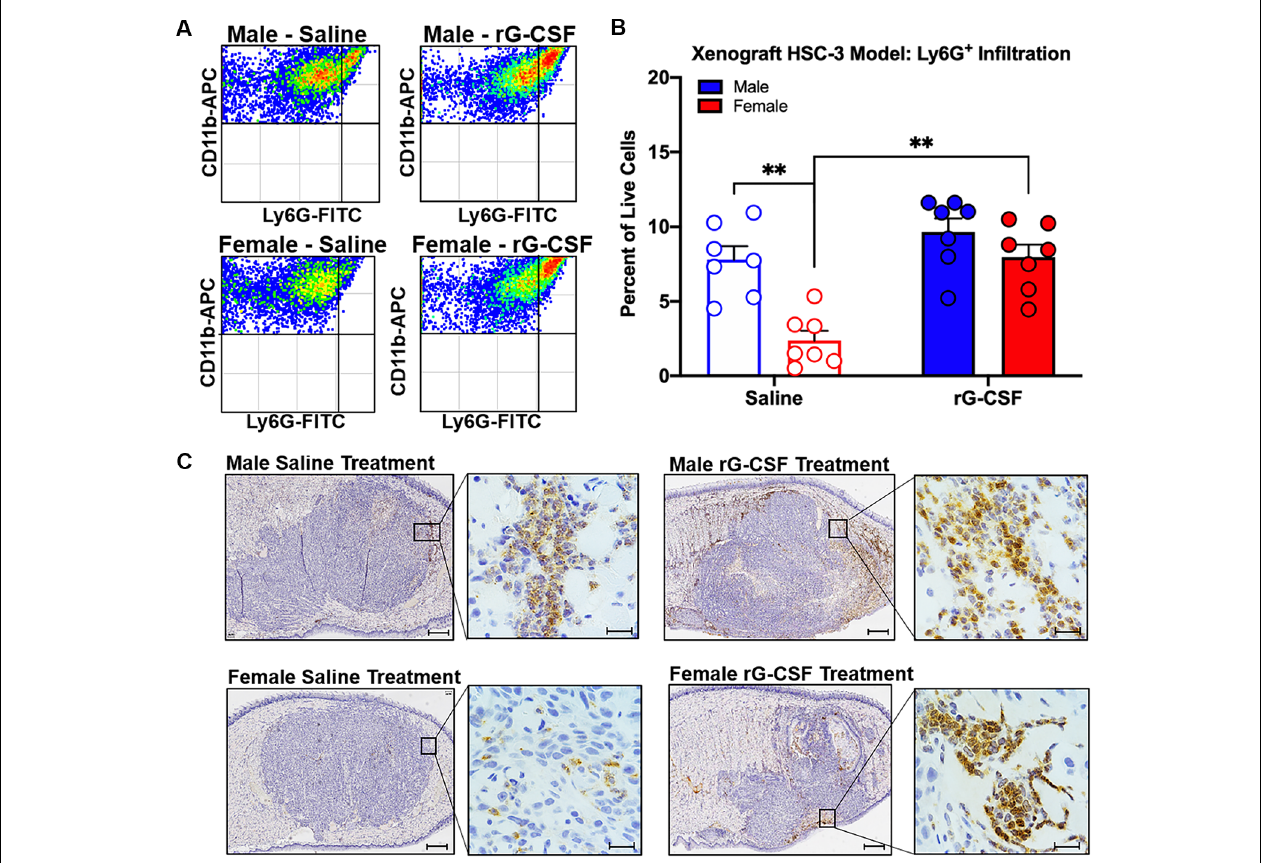
FIGURE 6 | HSC-3 xenograft-induced immune filtration was measured at post-inoculation day (PID) 38. (A) Representative scatter plots showing CD11b + Ly6G + neutrophils from the tongue of adult male (top plots) and female (bottom plots) nude mice after chronic saline (left side) or rG-CSF (right side) treatment. (B) Average Ly6G + neutrophil quantification in the xenograft tongues of male (blue bars) and female (red bars) mice after chronic saline ( N = 6/sex) or G-CSF ( N = 6/sex) treatment. Two-way ANOVA, ∗∗ P < 0.001. (C) Immunohistochemical analysis of saline-treated (left) and rG-CSF (right) treated male (top) and female (bottom) mouse tongues. HSC-3 xenograft tumors were stained with Ly6G (1A8) in diaminobenzidine (DAB) and counterstained with hematoxylin. Magnification is 2.5 × with 60 × insert. Scale bar 500 µ m (2.5 × ) and 20 µ m (60 × ).